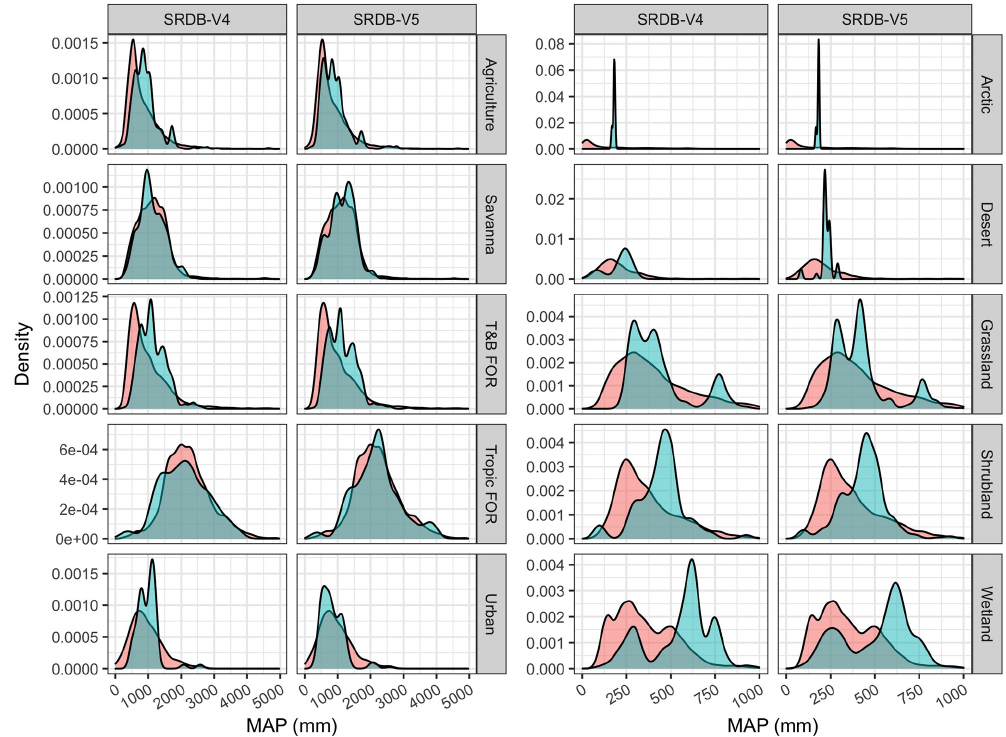
Figure 4. Comparison of mean annual precipitation (MAP; mm) around the globe (in red) vs. MAP from the sites in the global soil respiration database (SRDB; in teal) by the vegetation types. SRDB-V4 is the older SRDB published in 2018, and SRDB-V5 is the newest SRDB published in 2020. Data from SRDB covered 10 vegetation types (see Fig. 3). Sites from agriculture, savanna, forest, and urban generally well represent the global MAP (left panel), while sites from arctic, desert, grassland, shrubland, and wetland (including peatland) do not have a good MAP representation (right panel). Note that the barren region was masked using MODIS land cover data. The number of records of each panel is the same as Fig.